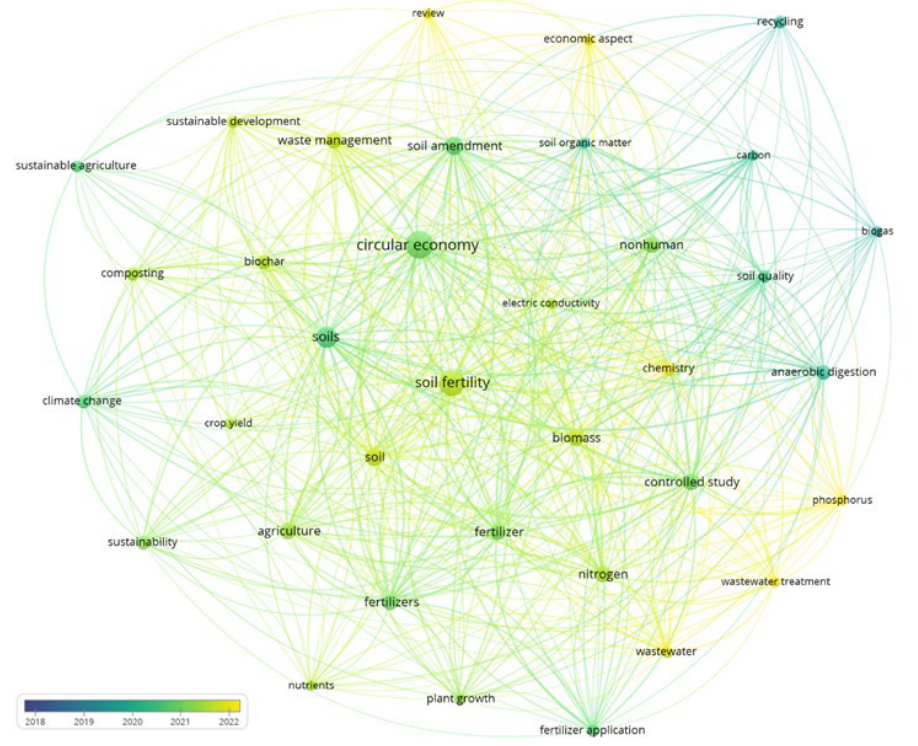
Figure 2. Chronology map of the keywords related to “circular economy” and “soil fertility” in the documents indexed by Scopus, 2018 –2022.